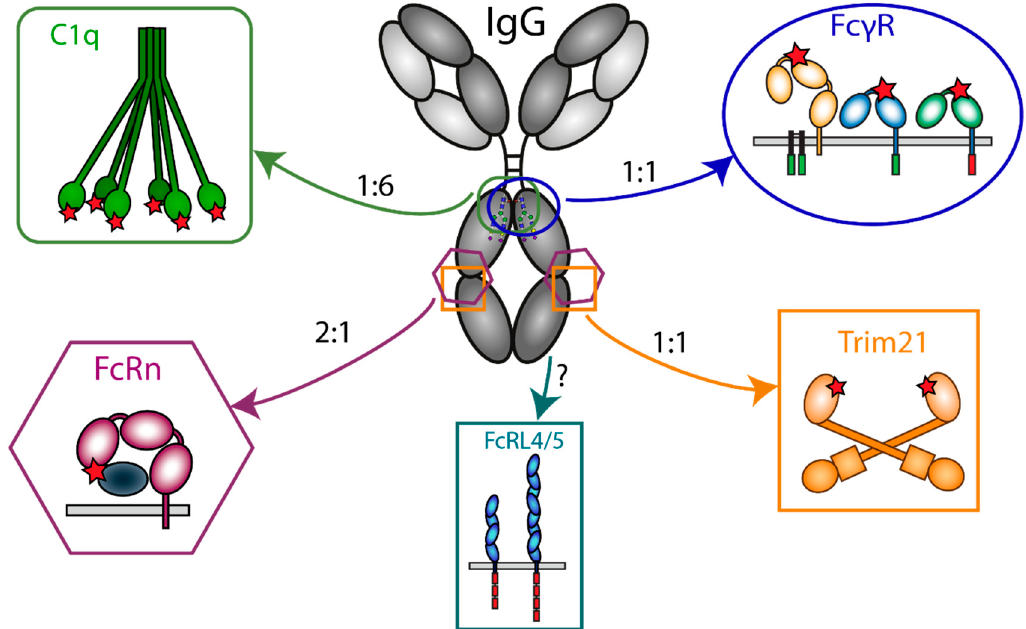
Figure 2. Interaction of IgG with Fc effector molecules. Schematic representation of IgG- and all Fc-engaging molecules (Complement component (C1q), Fc gamma receptors (Fc γ R), the Neonatal Fc receptor (FcRn), Tripartite motif 21 (Trim21), and Fc receptor-like (FcRL) molecules 4 and 5) through which antibodies exert their biological activity. For each ligand the binding site on IgG and the stoichiometry of the interaction with IgG is indicated. The red stars represent the binding site of IgG on the Fc effector molecules.